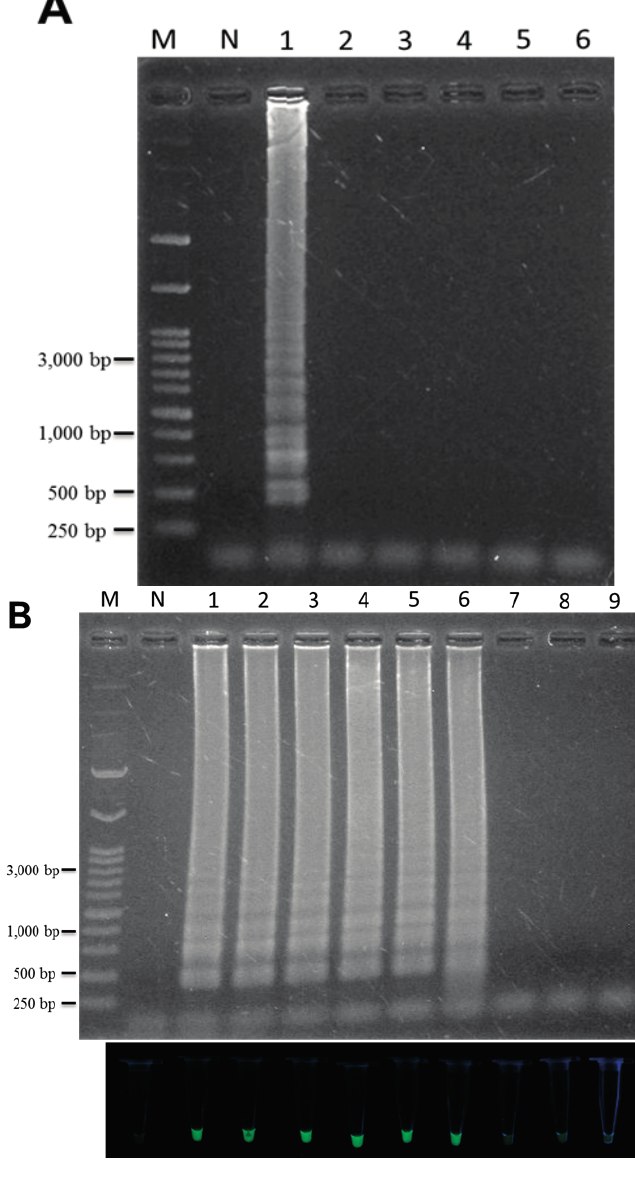
Figure 3. Specificity of the LAMP assay for the authentication of T. formosanum ( A ). The LAMP reactions were performed using specifically designed LAMP primers of TF. Lane M, 1 kb of DNA marker; lane N, without plant genomic DNA; lanes 1, Taraxacum formosanum ; lane 2, Taraxacum officinale ; lane 3, Ixeridium laevigatum ; lane 4, Youngia japonica ; lane 5, Ixeris chinensis ; lane 6, Emilia sonchifolia var. javanica ; Sensitivity analysis of the LAMP assay for the authentication of T. formosanum ( B ). The LAMP reaction was performed using various quantities of genomic TF DNA as template. The upper panels represent LAMP products detected by DNA electrophoresis; the lower panels represented LAMP products detected by SYBR Green I staining and UV excitation. Lane 1, 100 ng; lane 2, 20 ng; lane 3, 1 ng; lane 4, 100 pg; lane 5, 10 pg; lane 6, 1 pg; lane 7, 100 fg; lane 8, 10 fg; lane 9, 1